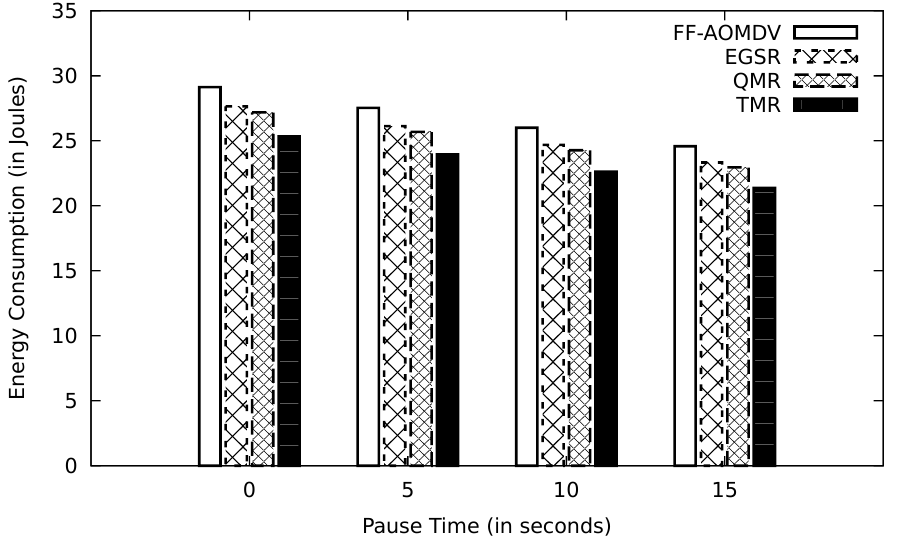
Figure 8. Comparison of FF-AOMDV, EGSR, QMR, and proposed protocol TMR for energy consump- tion with pause